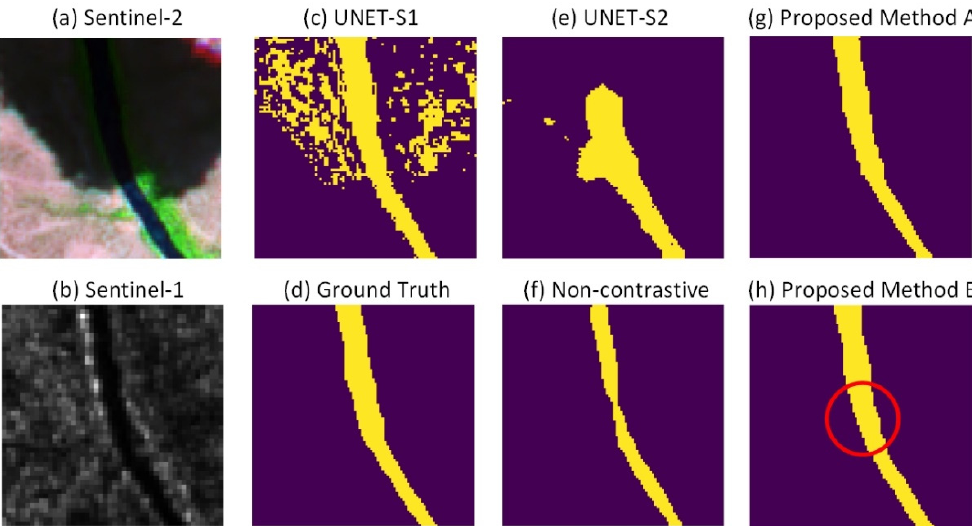
Figure 9. The performance of the proposed method and other state-of-the-art methods on large-scale river segmentation with 400 training samples. ( a ) test sample’s false color composite image based on Sentinel-2 satellite data; ( b ) test sample’s false color composite image based on Sentinel-1 satellite data; ( c ) UNET for Sentinel-1; ( d ) test sample’s ground truth; ( e ) UNET for Sentinel-2; ( f ) non-contrastive method is designed to show the performance of the proposed method without the common information path, by blocking the common information path in the proposed structure; ( g ) proposed method A; ( h ) proposed method B. The red circle in ( h ) represents the significate segmentation result improvement of the proposed method B, while comparing with other state-of-the-art methods.